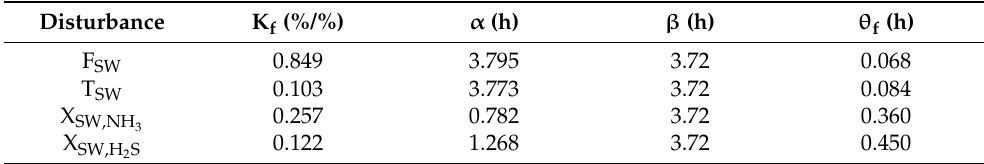
Table 3. Parameters of feedforward controller transfer functions for sour water feed stream distur-